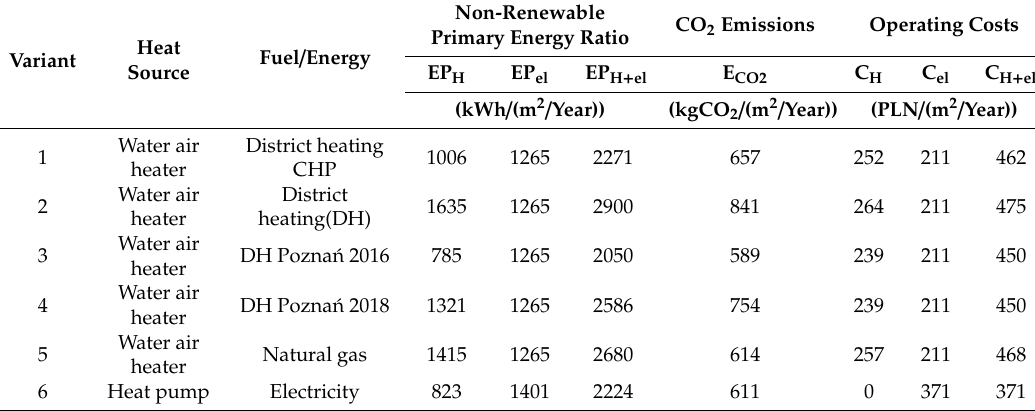
Table 8. Results of the calculations of the non-renewable primary energy ratio EP, CO 2 emissions E CO2 , and operating costs C—recreation pool